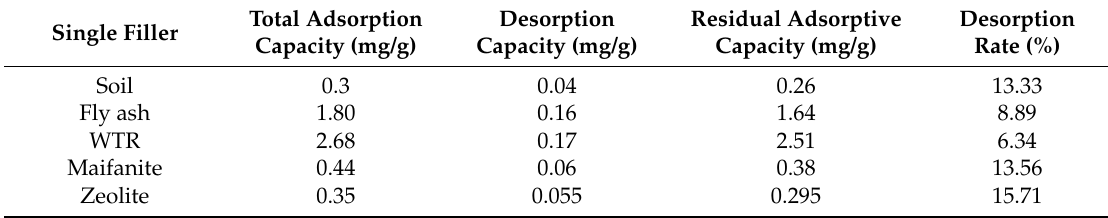
Table 5. Experimental results of phosphorus adsorption by single fillers.